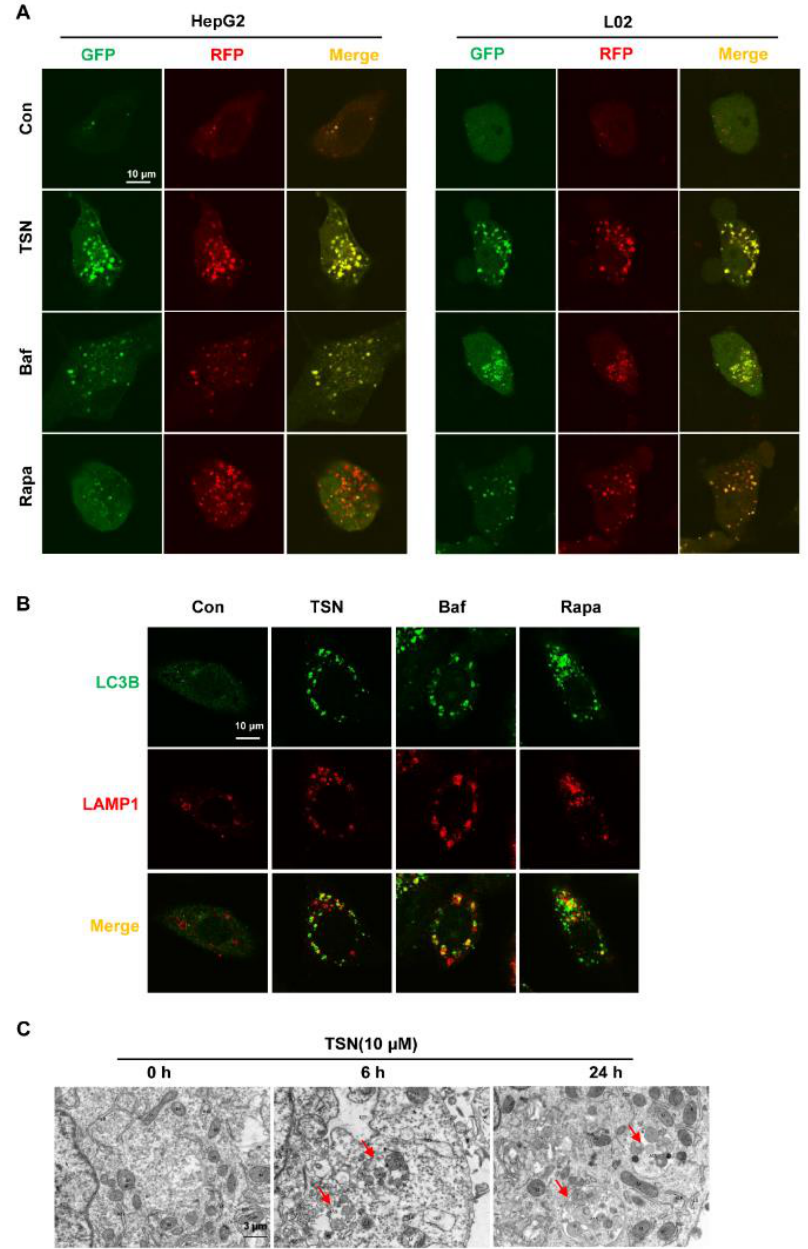
Figure 3. TSN increased the accumulation of autolysosomes in HepG2 cells and L02 cells. ( A ) HepG2 cells and L02 cells transfected with an RFP – GFP – LC3 tandem sensor were treated with TSN (10 μM), bafilomycin A1 (Baf, 0.5 µ M), or Rapa (1 µ M) for 6 h. The colocalization of GFP and RFP puncta was imaged using confocal microscopy. Scale bar: 10 μm. ( B ) HepG2 cells were treated with TSN (10 μM), Baf (0.5 μM) , or Rapa (1 μM) for 6 h, and then cellular immunofluorescence staining was used to detect the colocalization of LC3B and LAMP1. Scale bar: 10 μm. ( C ) HepG2 cells were treated with TSN (10 μM) for a certain time course (0, 6, 24 h), and then transmission electron microscopy (TEM) was used to detect the ultrastructure of HepG2 cells. Red arrows indicate autolysosome struc tures. Scale bar: 3 μm. Data are presented as the representative figures of three independent experiments.